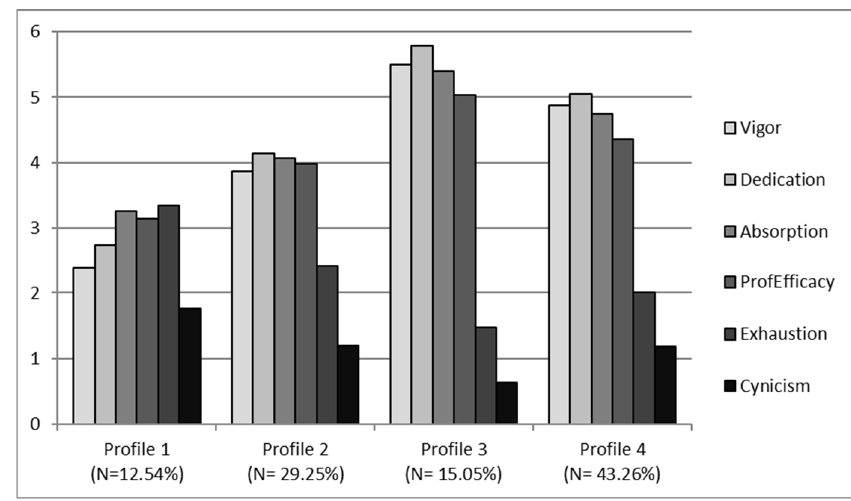
Figure 2. Profile distribution in TRAS.